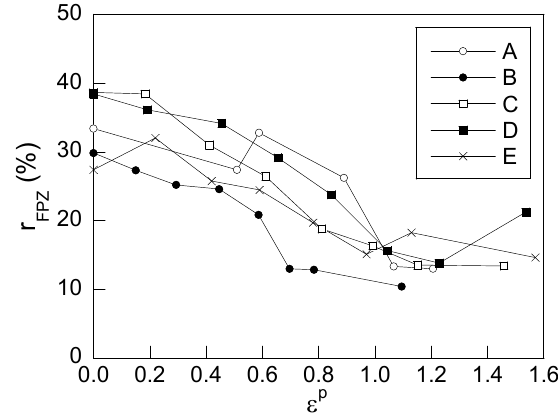
Figure 14. Evolution of radius of the FPZ with the drawing degree.